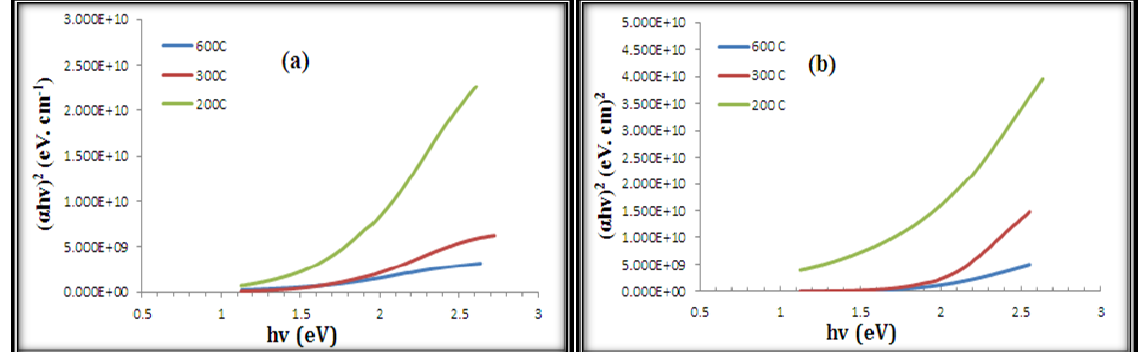
Fig.12: The variation of (αhv) 2 versus the photon energy (hv) of Ag sintered at different temperature (a) as deposited (b) annealed at 200 °C for half an hour.